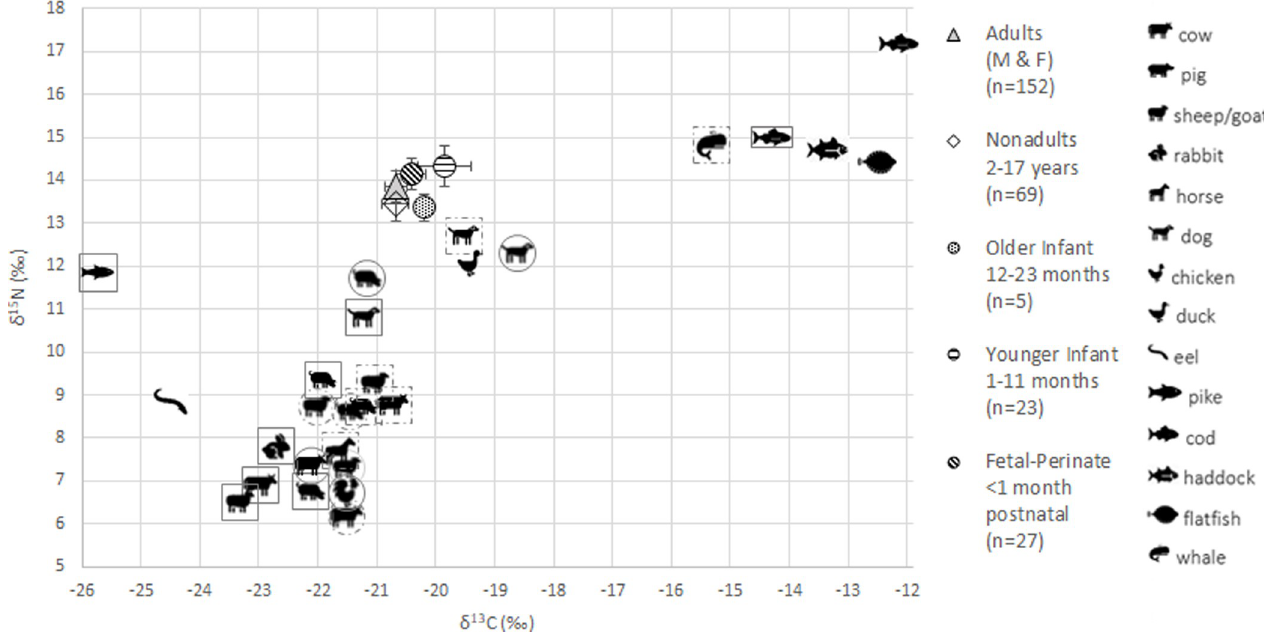
Fig 4. Scatterplot of certain Middenbeemster age-group δ 13 C and δ 15 N results with published archaeological faunal isotope results from five medieval Dutch sites. Symbols in solid square = site of Sint-Oedenrode [81]; dashed square = site of Oosterbeintum [83]; solid circle = site of Canadaplein, Alkmaar [82]; dashed circle = site of Doelenstraat, Alkmaar [82]; no border = site of Oldenzaal